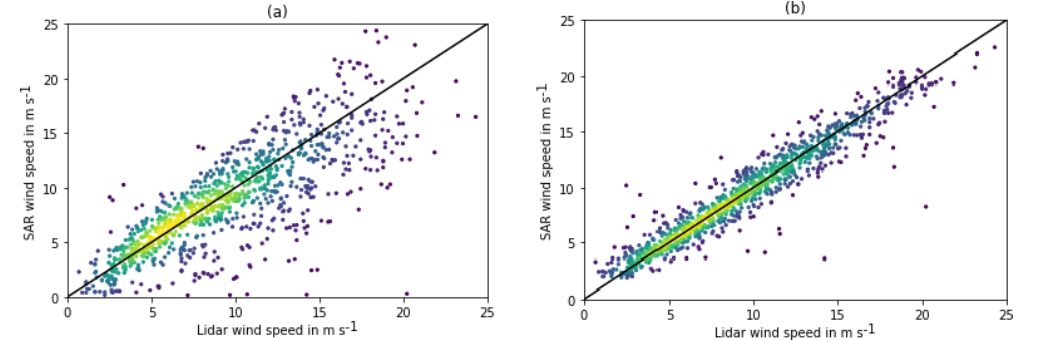
Figure 8. Scatter plots between SAR and lidar wind speeds at 120ma . s . l . when the extrapolation is performed with a classical power law (a) or with machine learning (b) . The colours represent the density of points, and the black curve is the identity line.